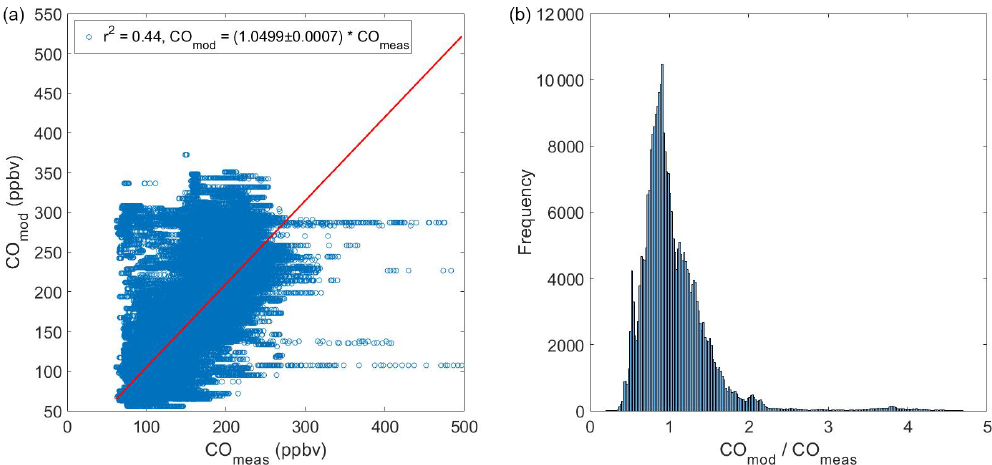
Figure 3. (a) Linear regression of modeled vs measured carbon monoxide (CO) mixing ratio (in ppbv) and (b) histogram of the ratio of modeled-to-measured CO over the full DISCOVER-AQ campaign.